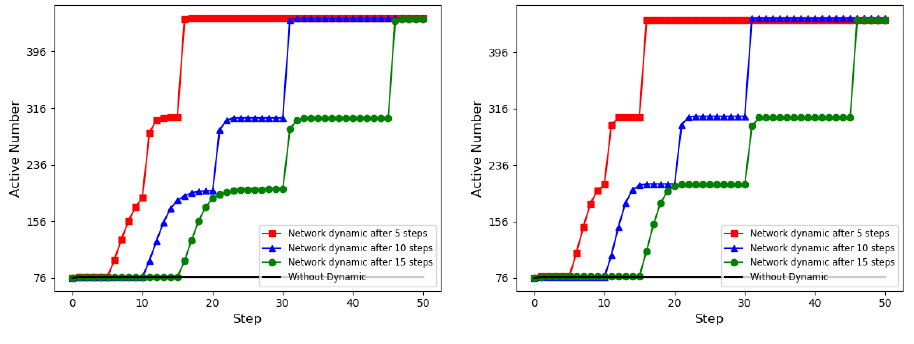
Fig. 7. Textual-Homo-IC di®usion on dynamic Twitter